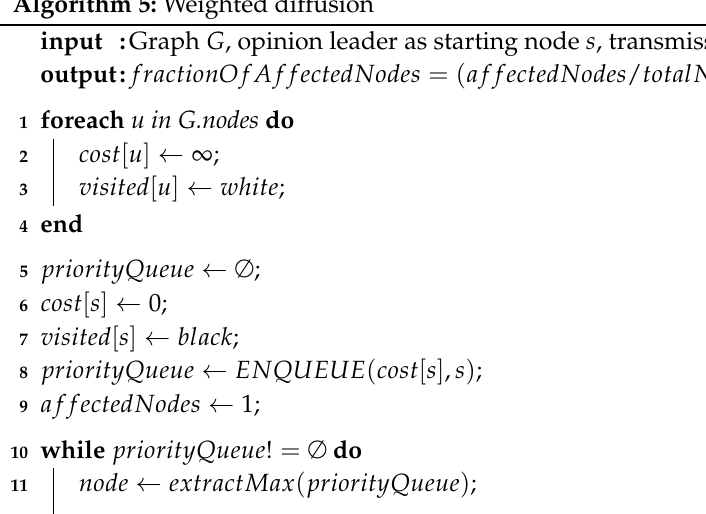
Algorithm 5: Weighted